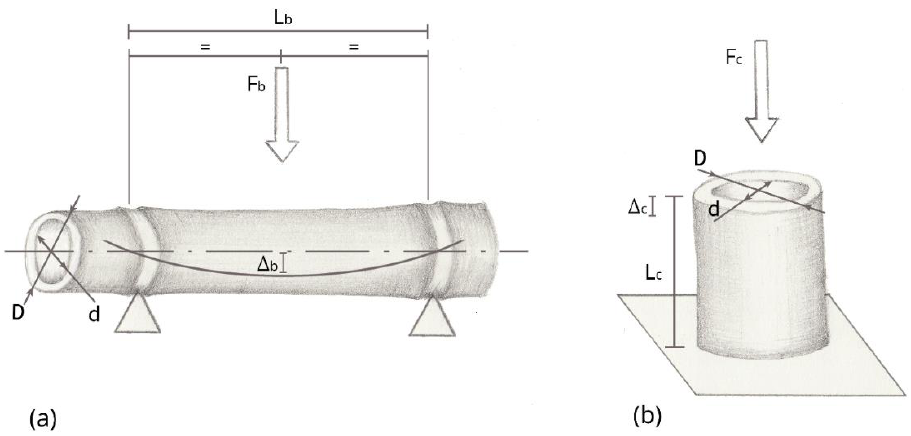
Figure 3. Mechanical tests diagrams: ( a ) bending test; ( b ) compression test.